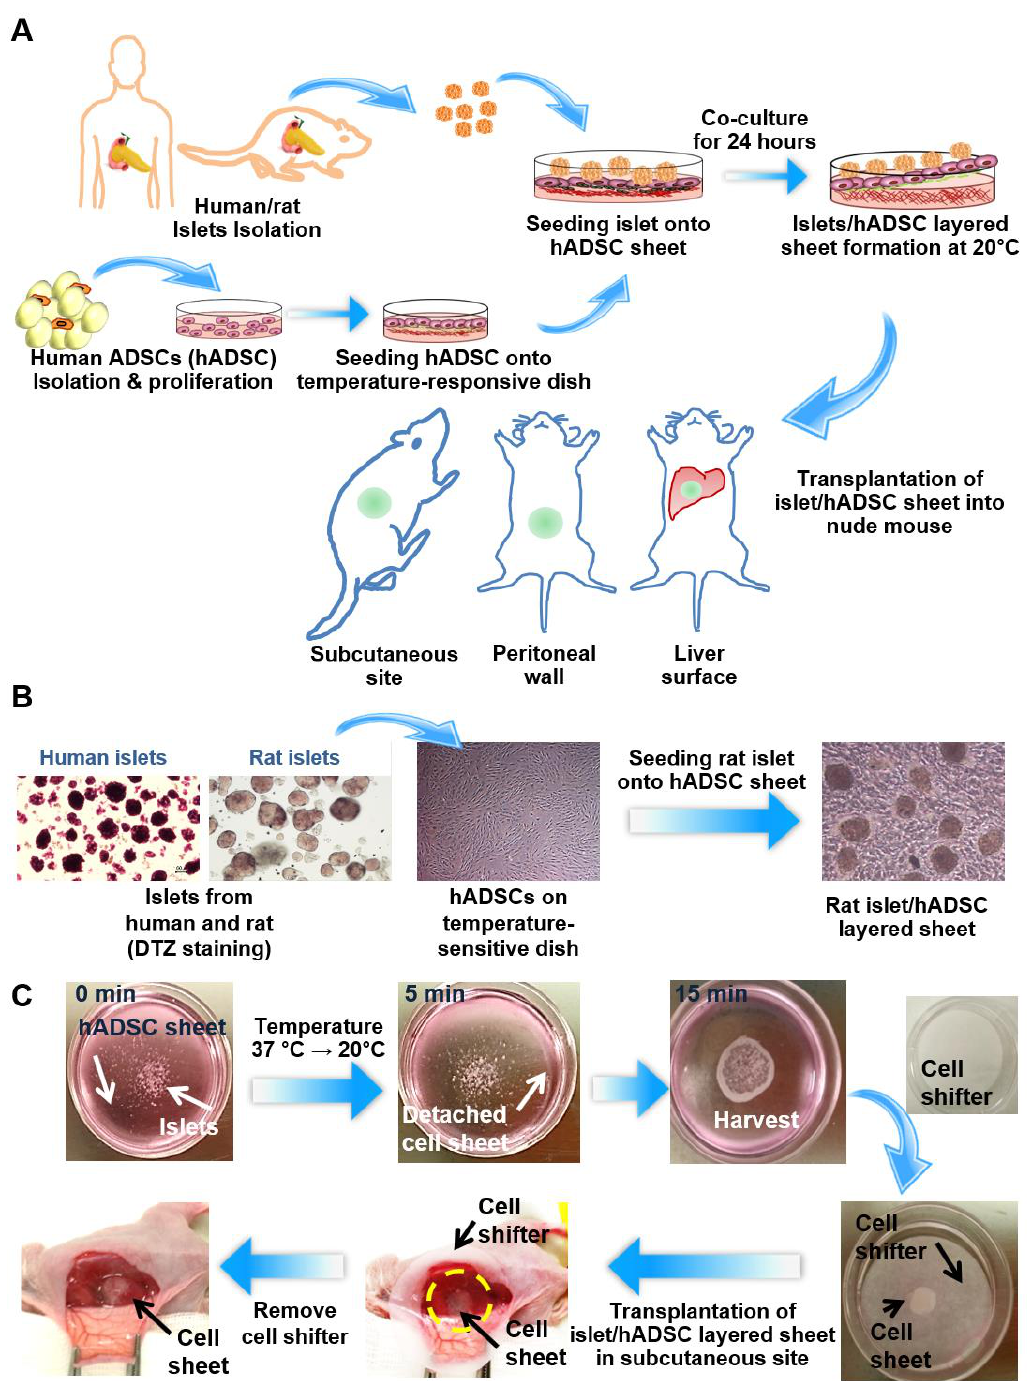
Figure 1. Multi-layered islet/adipose-derived stem cell (ADSC) sheet co-culture model and transplantation in three different sites. ( A ) Schematic diagram of layered Islet/ADSC (AI) sheet co-culture. Islets were isolated from humans and rats. Human ADSCs (hADSCs) were isolated from human fat tissue and cultured on temperature-response dishes to produce cell sheets. Isolated islets were seeded on ADSC sheets after the hADSCs reached confluence and were harvested after layered co-culture for 24 h. AI sheets were transplanted in the subcutaneous site, peritoneal wall, and liver surface. ( B ) Microscope image of isolated islets, an hADSC sheet, and an AI multi-layered sheet. ( C ) Experimental procedure of layered AI sheet co-culture and transplantation into the subcutaneous site.